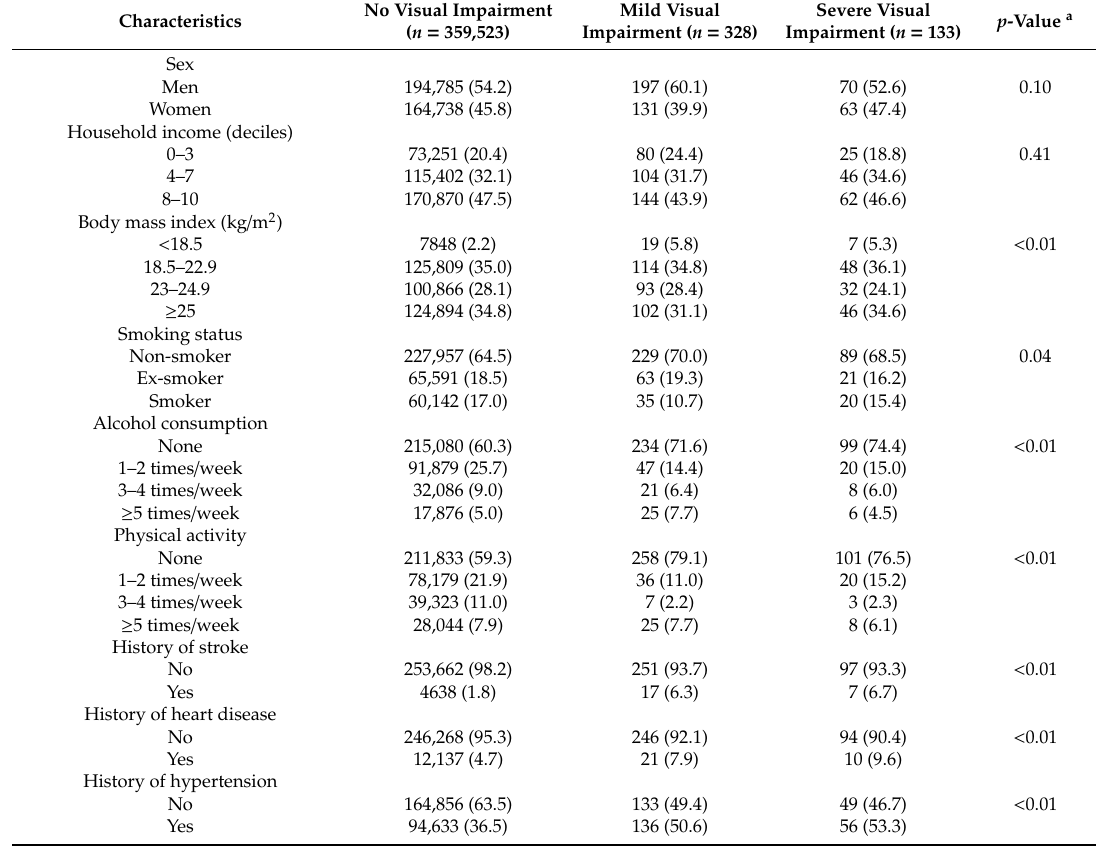
Table 1. Sociodemographic characteristics of the study participants by visual function ( n = 359,984).